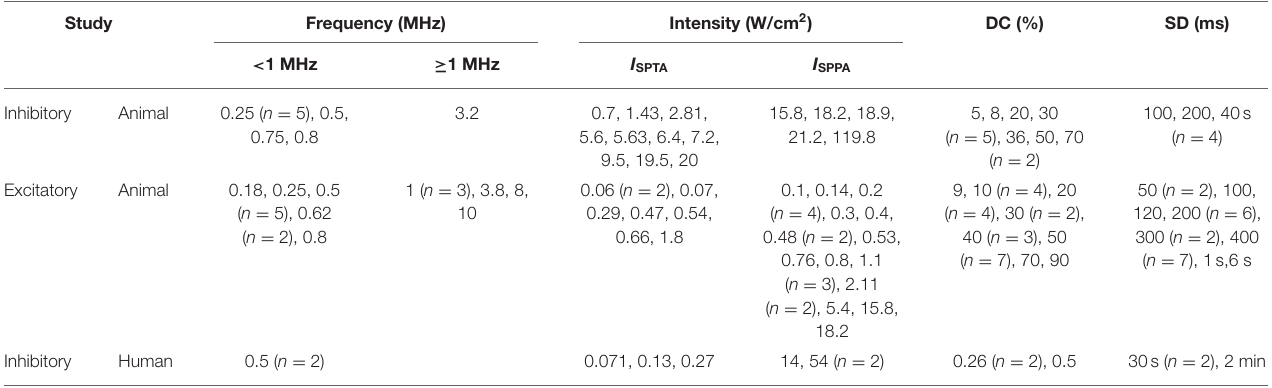
TABLE 2 | Summary of key ultrasonic parameters by neuromodulatory